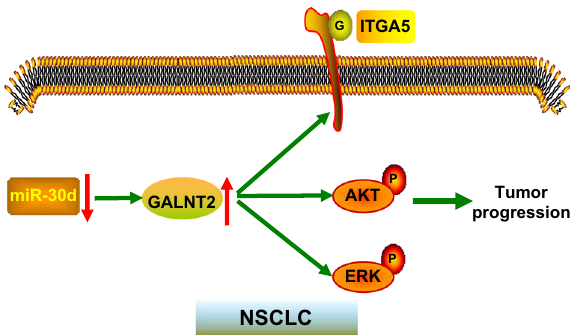
Fig. 10 A proposed model for the regulatory mechanism of GALNT2. G: O -glycosylated; P: